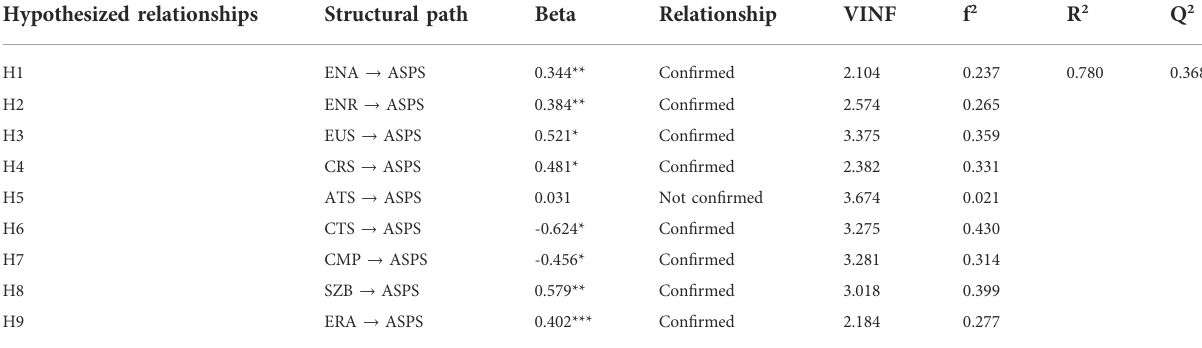
TABLE 3 Results of structural modeling.